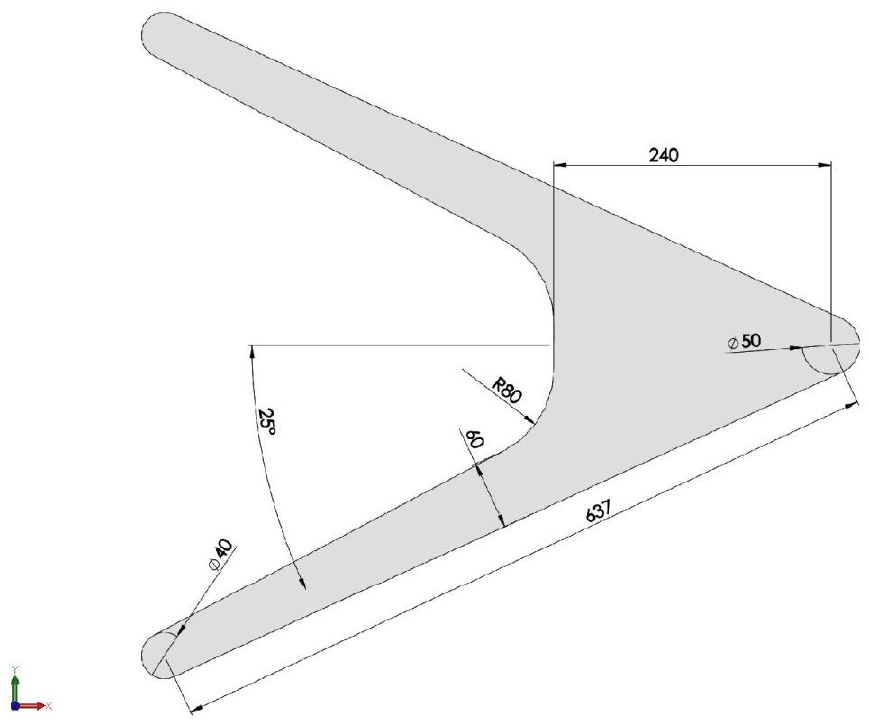
Figure 13. Delta VLFS with stern radius R 3 = 20 m (40 m stern diameter).